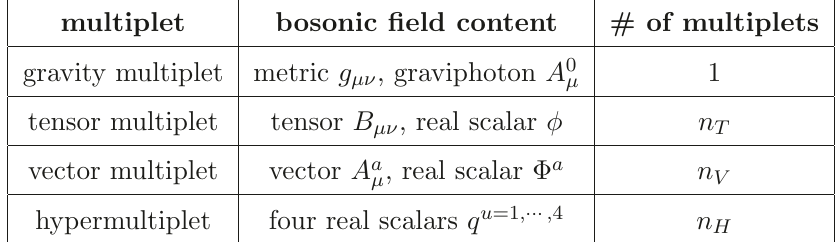
= 2 supergravity and their field N